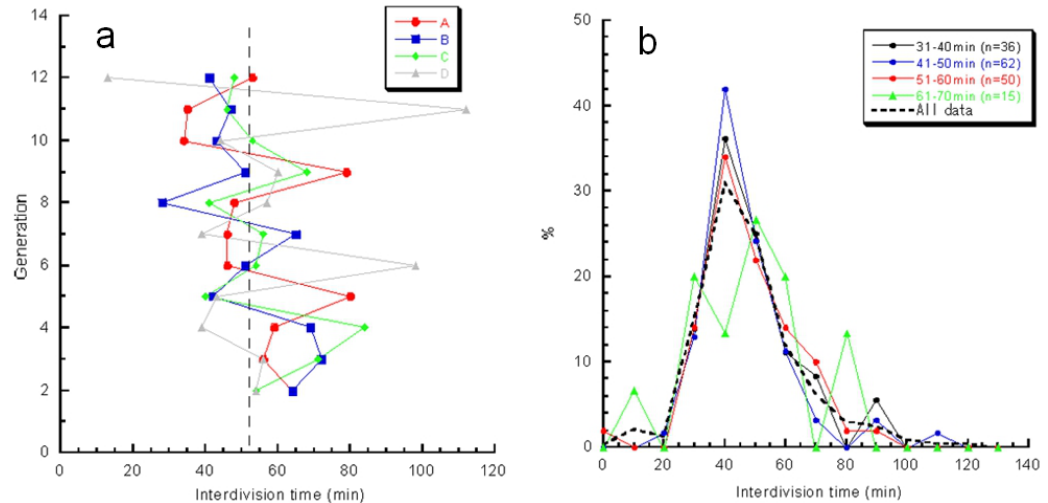
Figure 13. Genetic variations in direct descendant cells of E. coli. ( a ) Interdivision time of generations of direct descendant cells of four sister cells. ( b ) Interdivision time dependence of populations of direct descendant cells in